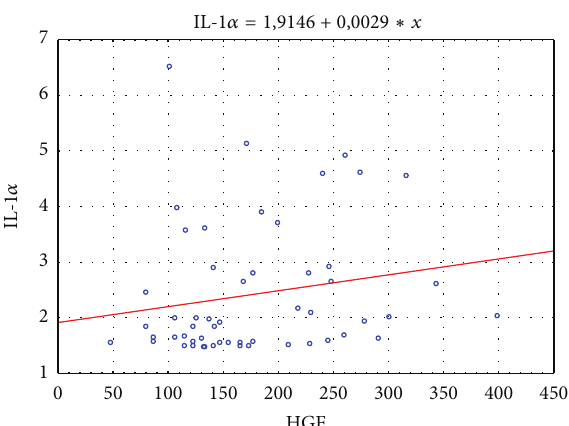
Figure 8: Relationships between HGF and stage of liver cirrhosis. Key: 0: alcoholics without liver cirrhosis; A, B, and C: alcoholics with liver cirrhosis Pugh-Child stages A–C; K: healthy